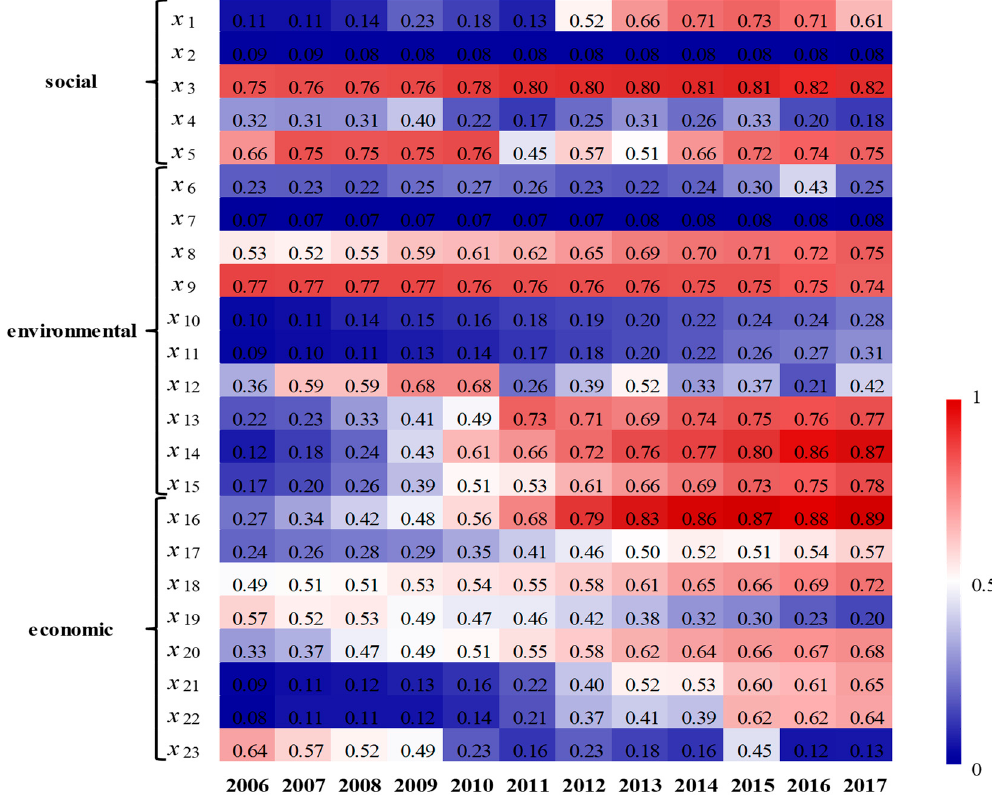
Figure 4. Comprehensive index of indicators in 2006–2017.